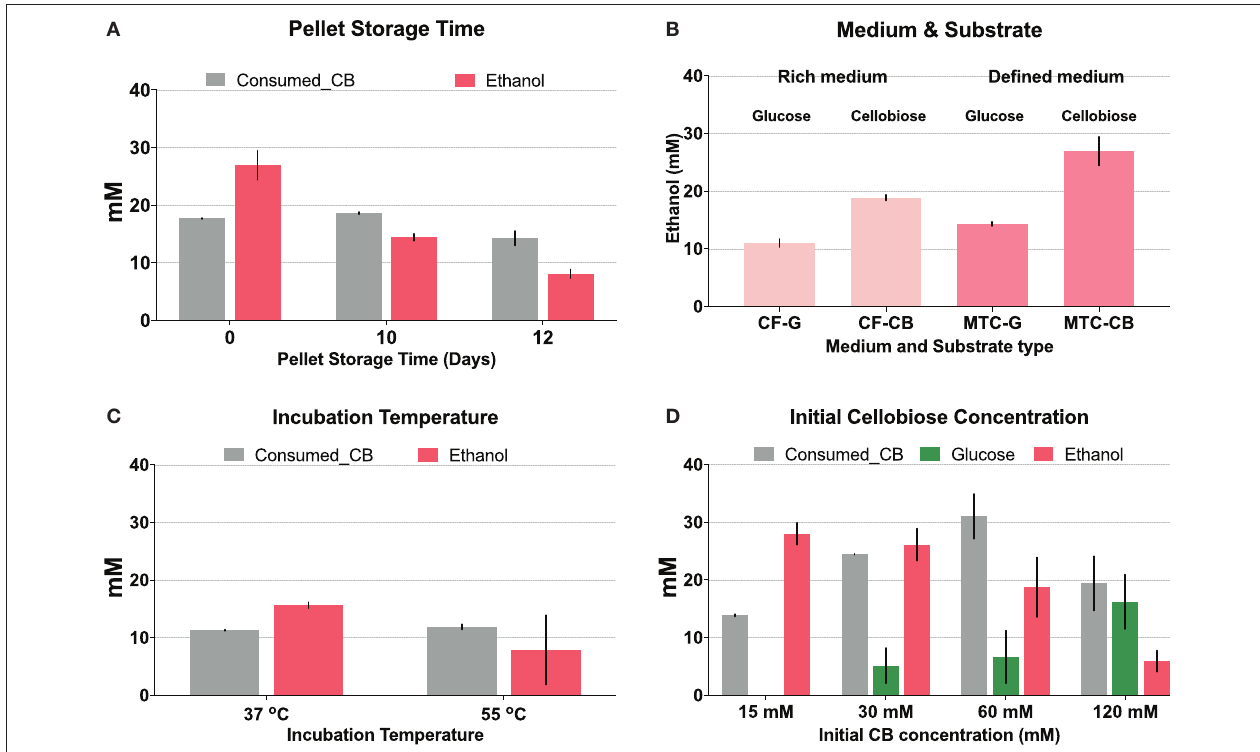
FIGURE 2 | Optimization of the cell-free extract reaction (CFER) system for improved ethanol production. Gray bars represent consumed cellobiose, red bars represent ethanol production, and green bars represent glucose production. (A) The CFER system using cell pellets stored at − 80 ◦ C for different amounts of time before lysis. Cell pellets were prepared from cells grown in MTC-5 with cellobiose as substrate and kept frozen at − 80 ◦ C for 10 or 12 days. The CFER system was started with 15mM ( ∼ 5 g/L) cellobiose and incubated at 37 ◦ C for 48h to measure ethanol production. Error bars represent one standard deviation from two replicates. (B) The CFER system using cell pellets grown in different medium and substrate combinations. CF, CTFUD; MTC, MTC-5; G, glucose; CB, cellobiose. Error bars represent one standard deviation from two replicates. (C) The CFER system incubated at different temperatures. Error bars represent one standard deviation from two replicates. (D) The CFER system with different initial cellobiose concentrations. Error bars represent 1 standard deviation from three replicates. Raw data for Figure 1 is included in Supplementary Table 2